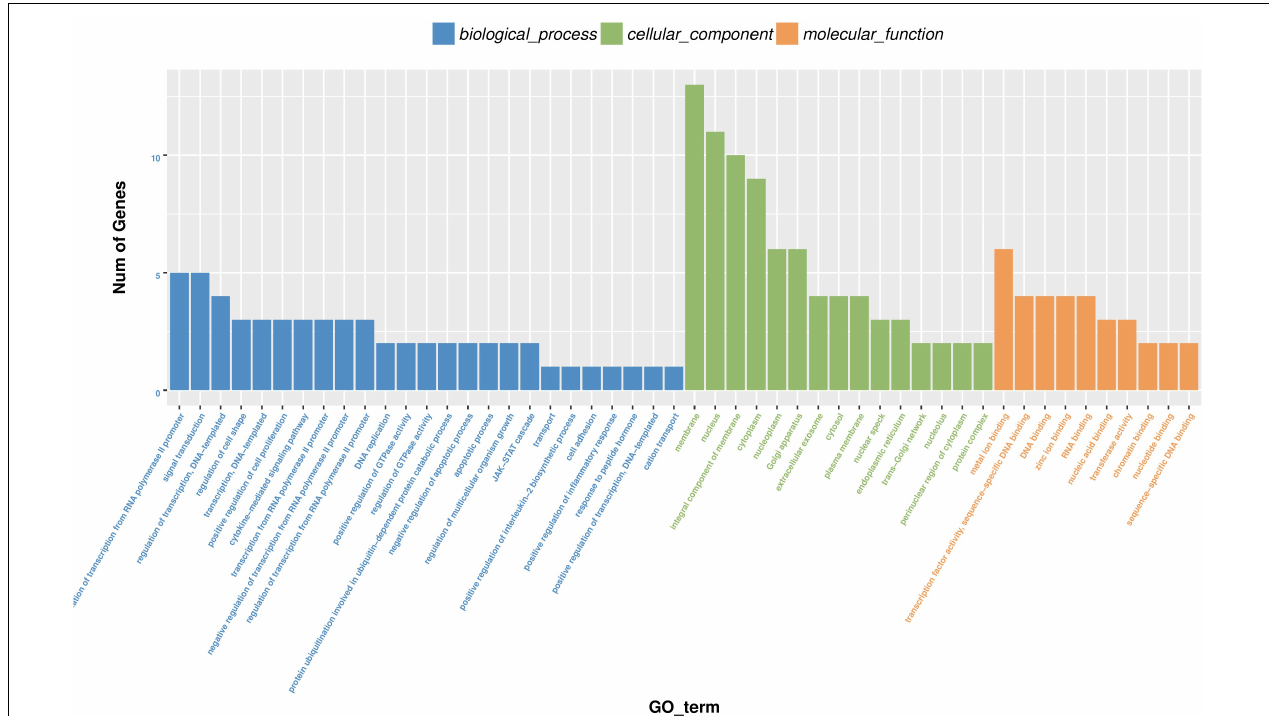
FIGURE 11 | Histogram of differential expression circRNA-hosting gene GO enrichment analysis. Take GO term as abscissa and Num of genes as